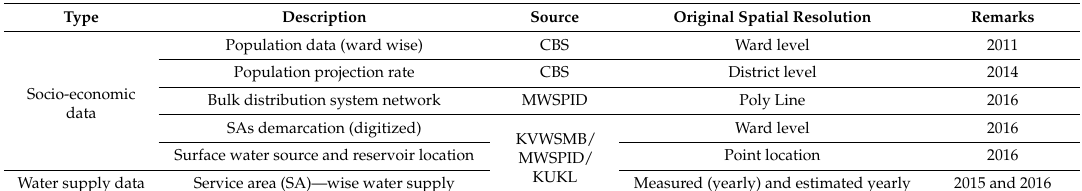
Table 2. Data used, source, and